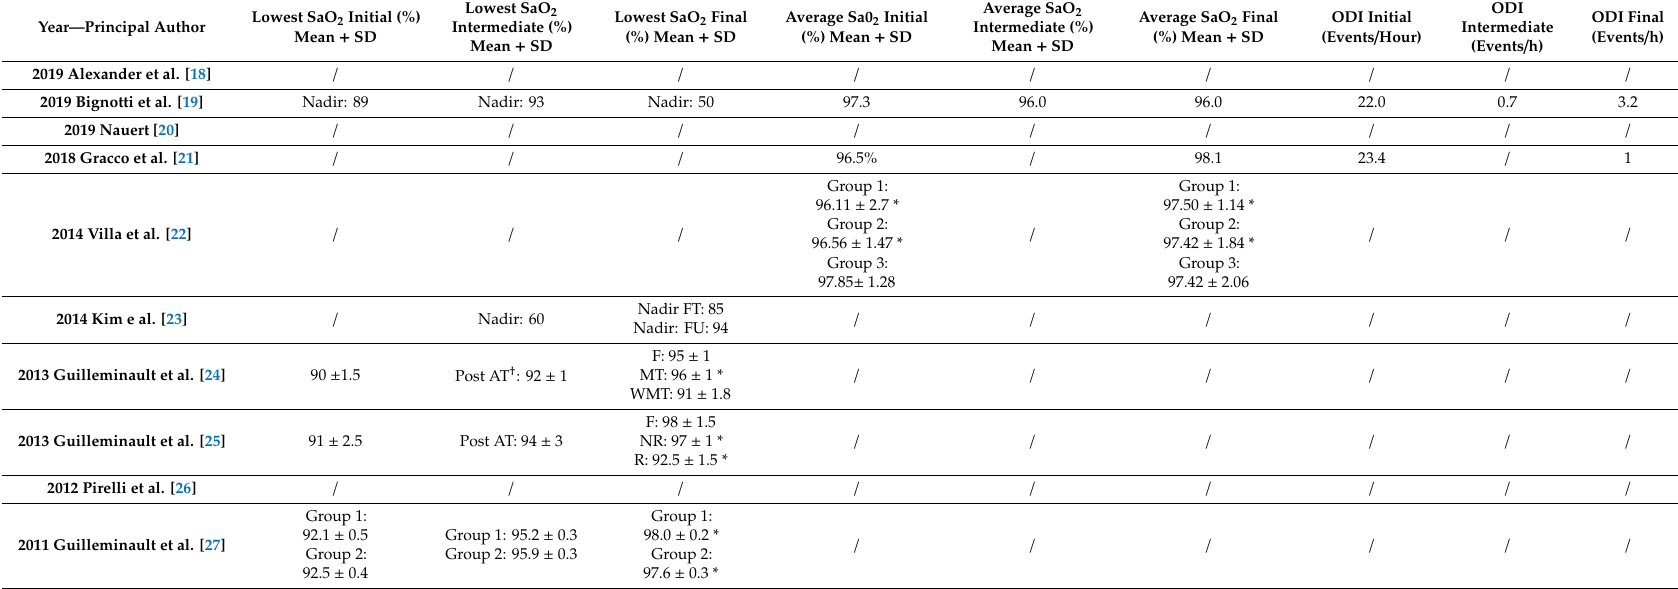
AT—adenotonsillectomy; MT—myofunctional therapy; WMT—without myofunctional therapy; F—final treatment; FU—follow-up; R—patients with relapse; NR—patients without relapse;